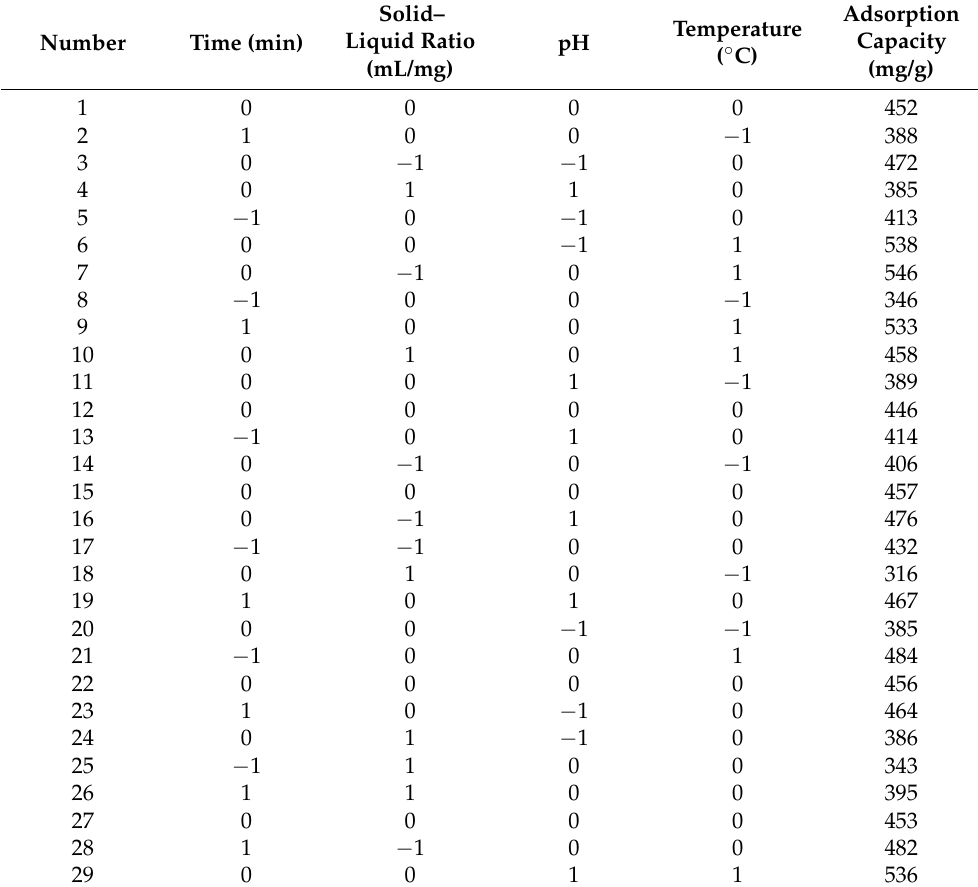
Table 8. The test design table and results of response surface method